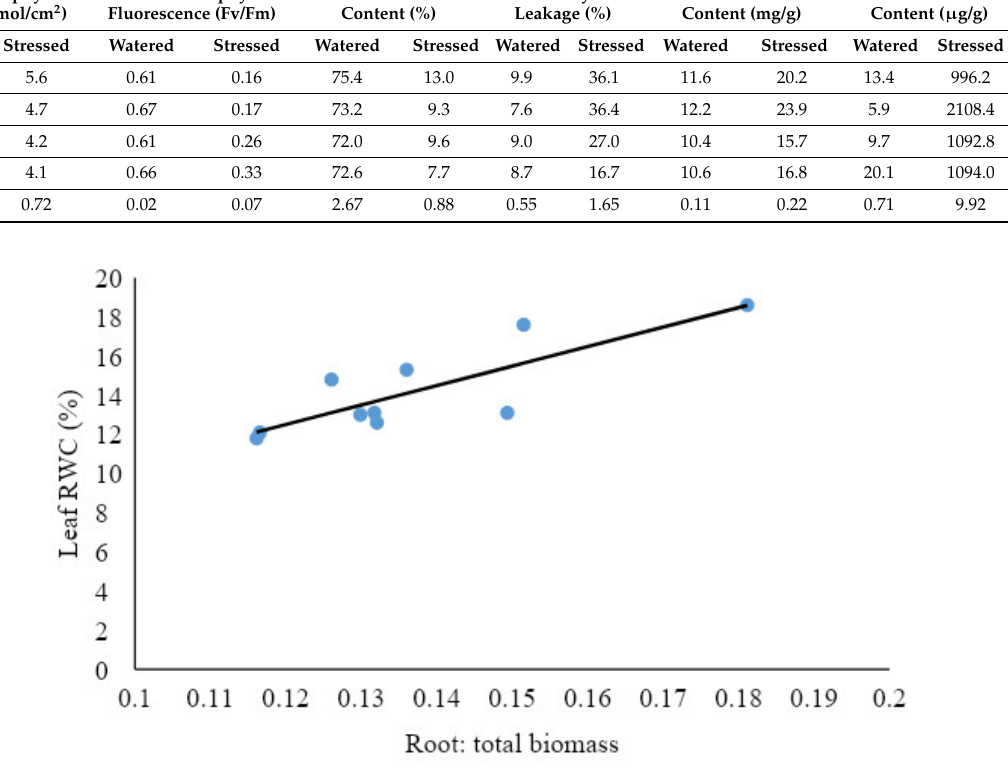
Figure 9. Relationship between leaf relative water content (RWC) and dry matter partitioned to roots of ten cocoa seedling varieties evaluated under 45 days of water stress in a gauzehouse facility.